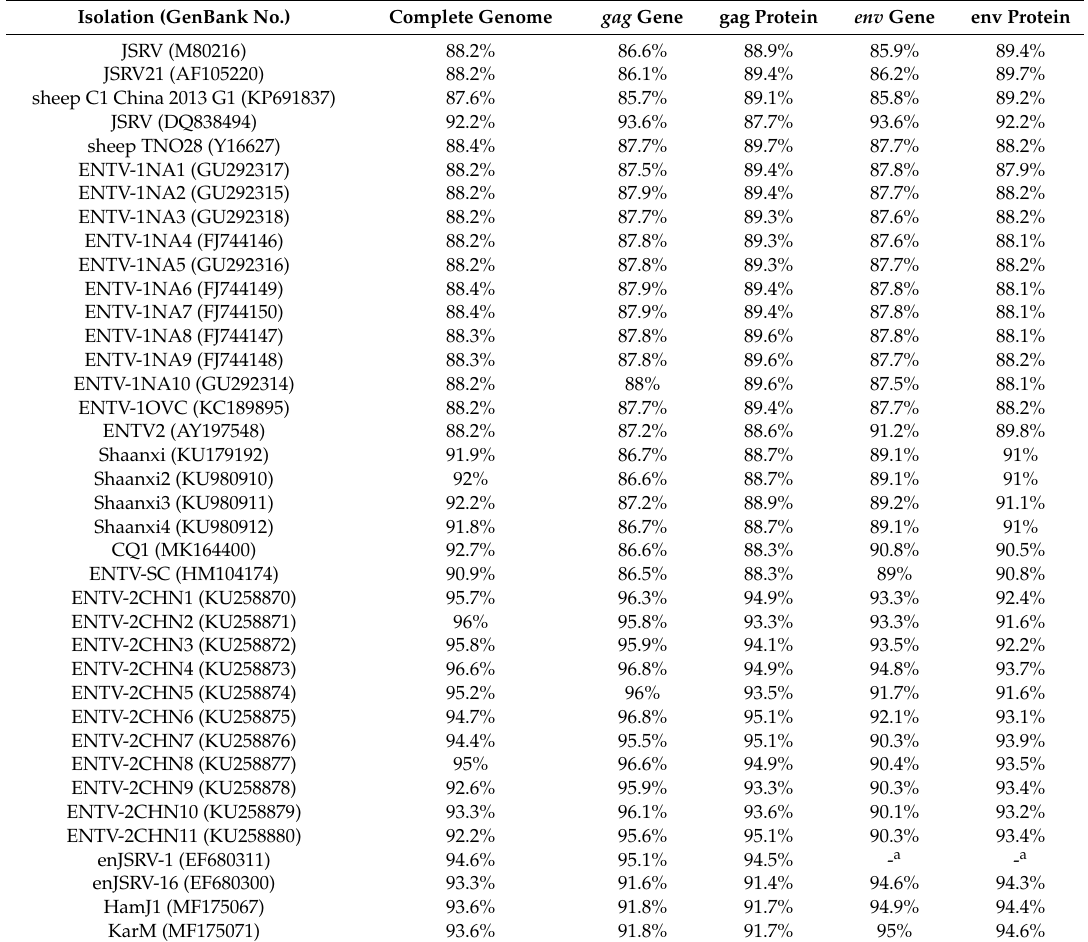
Table 2. Similarity (%) of GDQY2017 with other reference retroviruses in goats and sheep. Isolation (GenBank